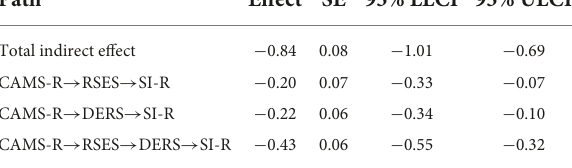
TABLE 5 Results of indirect effects (5,000 bootstraps).